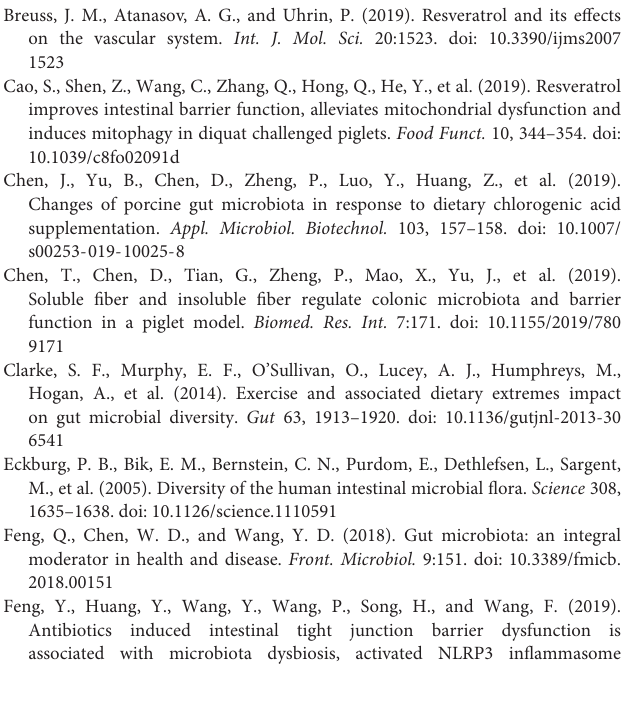
Supplementary Table 1 | Statistics of identified metabolites. Supplementary Table 2 | Statistics of identified metabolites: Differences in metabolites in the colon of RES and control groups in positive ion (A) and negative ion model (B) ,